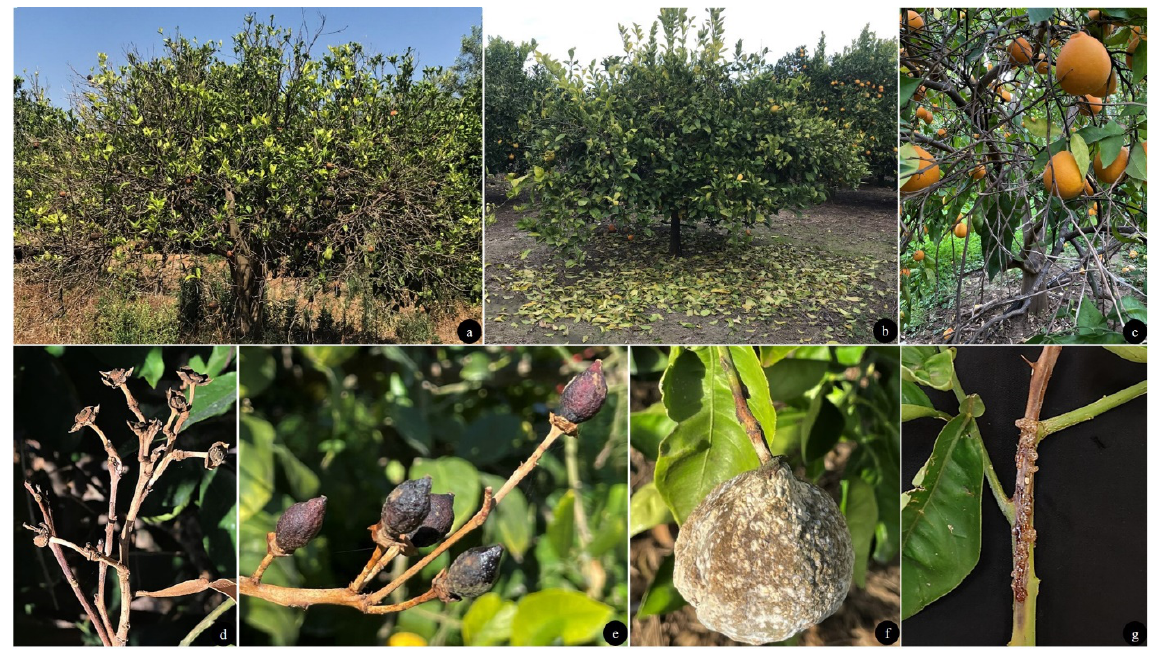
Figure 6. Twig dieback and defoliation: ( a ) severe twig dieback of “Tarocco Scir è VCR” tree; ( b ) severe defoliation of “Tarocco Scir é D2062 nucellare” tree; ( c ) detail of twigs blight on “Tarocco Sciara”; ( d ) blight of calyx and twigs of “Tarocco Meli”; ( e ) blight of fruitlet and twig of “Femminello Siracusano 2KR”; ( f ) mummified fruit with grey aerial hyphae of “Tarocco Sciara”; ( g ) gum exudation on “Tarocco Scir è VCR”